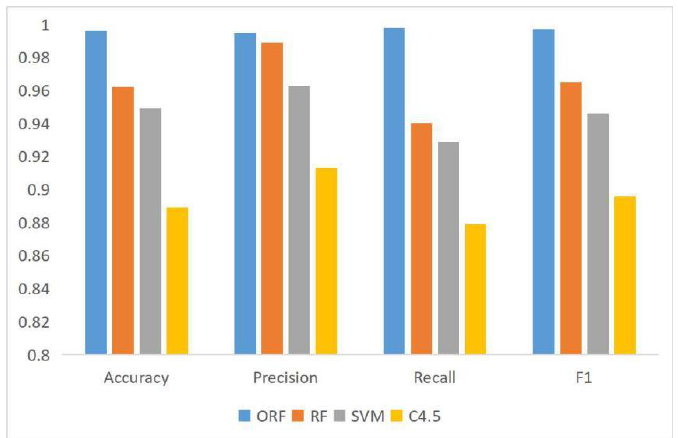
Figure 11. Performance comparison of classification model